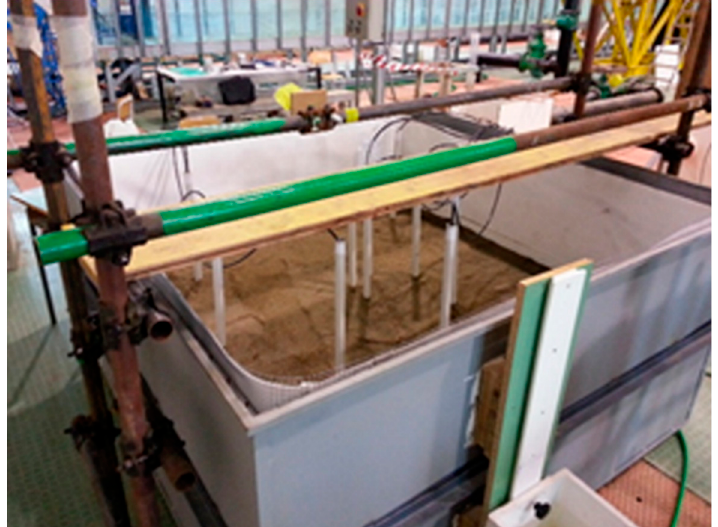
Figure 2. Experimental device, with pressure transducers inserted in the wells, located in the confined aquifer, as shown in Figure 1a.